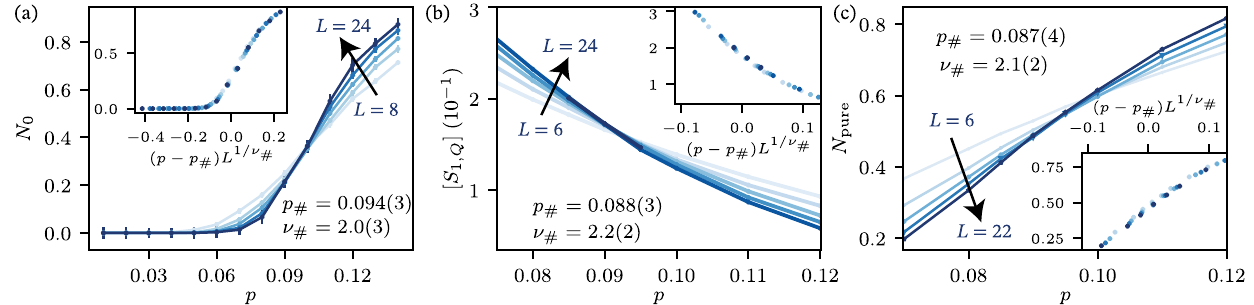
FIG. 3. Charge-sharpening transition in qubit chains. (a) Data and collapse of N 0 , the fraction of trajectories with δ Q 2 < ϵ used to determine the critical point of the charge-sharpening transition, p # ¼ 0 . 094 ð 3 Þ , and correlation length exponent, ν # ¼ 2 . 0 ð 3 Þ . The value of ϵ ¼ 10 − 2 is chosen such that it maximizes the quality of collapse at t=L ¼ 4 . The error bars in p # and ν # are estimated using the region [28]; see Fig. 5. (b) Data and collapse of the charge-sharpening transition in parameter space near the minimum such that χ 2 < 1 . 3 χ 2 min order parameter ½ S 1 used as an alternative method to determine the critical point of the sharpening transition, p # ¼ 0 . 088 ð 3 Þ , and the ;Q (cid:2) correlation length exponent, ν # ¼ 2 . 15 ð 15 Þ . (c) Data and collapse of the fraction of trajectories where the ancilla qubit is purified N at pure the charge-sharpening transition. The transition point p # ¼ 0 . 087 ð 4 Þ and the correlation length exponent ν # ¼ 2 . 1 ð 2 Þ are consistent with the ancilla probe. The critical point and the exponent obtained from ½ S 1 and N are estimated with a finite size scaling analysis as ;Q (cid:2) pure explained in Appendix D. Error bars on the data points are obtained from the error on the mean by computing the standard